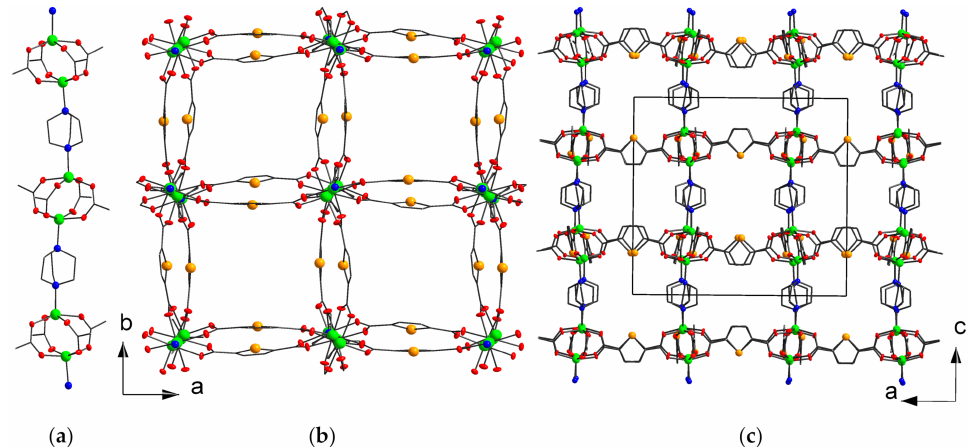
Figure 1. Crystal structure of 1se . A section of the structure showing dabco-bridged secondary building units {Zn 2 (OOCR) 4 } ( a ); 3D structure of the framework: view along c axis ( b ) and b axis ( c ). Zn atoms are shown green, N atoms—blue, O atoms—red, Se atoms—orange. H atoms and guest DMF molecules are not